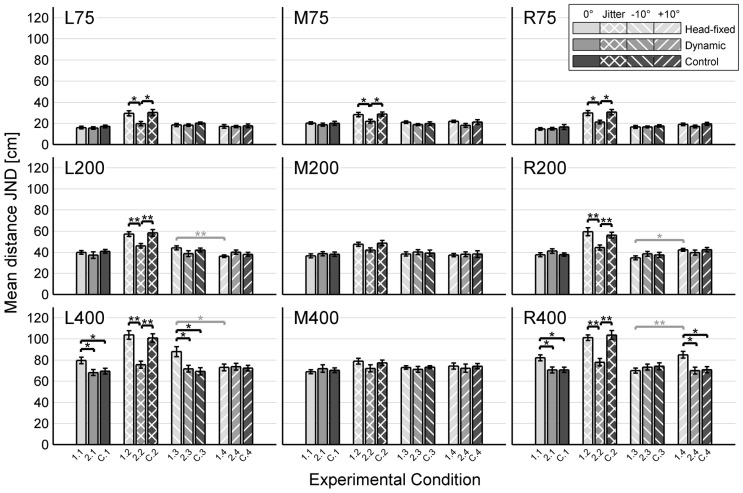
Results of all distance discrimination experiments.Performance is shown in terms of mean JNDs (averaged across six sighted subjects, error bars represent standard errors of the means), plotted against experimental conditions. Each panel represents one reference position (cf. Figs. 1, 2C). Experiments are encoded by different grey scales (light grey, grey and dark grey for Exp. 1, Exp. 2 and the control experiment, respectively). Conditions are encoded by different stripe patterns (no stripes for 0° initial orientation; stripes to the left or right for initial orientation of 10° to the left or right, respectively; stripes both to the left and right for jittered initial orientation). The same grey-scale- and stripe-pattern codes are used throughout this paper. Additionally, the horizontal axes are labelled with abbreviations for the respective experimental conditions (cf. Fig. 2A, B). These labels are redundant to the grey-scale- and stripe-pattern codes, however they might be convenient for the reader since the abbreviations are used in the text to refer to specific experimental conditions. The stars highlight significant differences between pairs of experimental conditions (Wilcoxon-rank-sum test, * for p<0.05, ** for p<0.01). There were no significant differences between the non-jittered conditions (0°, −10°, +10°) and there were no significant differences between the left side (L75, L200, L400) and the right side (R75, R200, R400), except from experiments 1.3 and 1.4 at reference distances of 2 and 4 m. These exceptions are marked with grey significance bars.